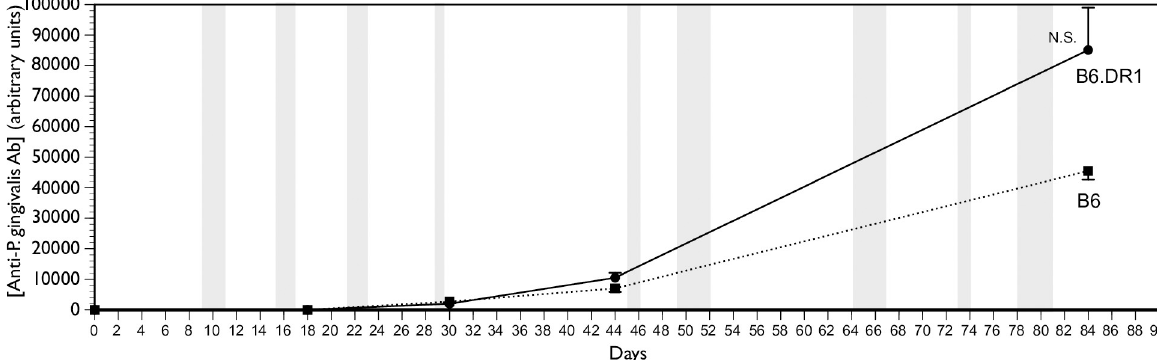
Fig 2. Both B6 and B6.DR1 make antibodies to P . gingivalis . Serum samples from both B6 and B6.DR1 mice taken at time points both before and after several rounds of inoculation with P . gingivalis reveal that both strains produce antibody to the pathogen at similar titers. NS = not statistically